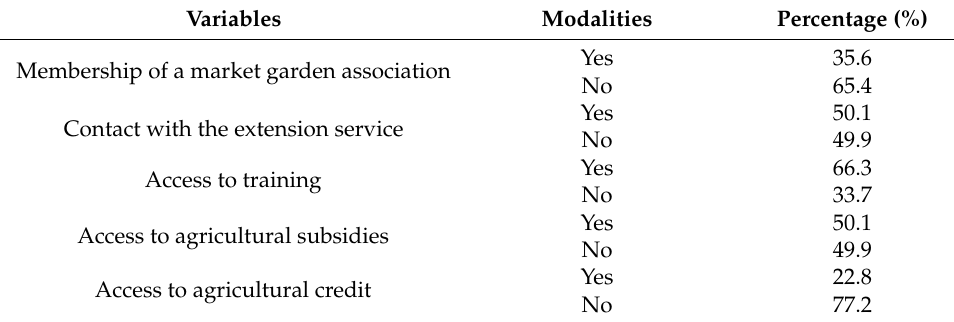
Table 5. Farmers’ institutional characteristics.